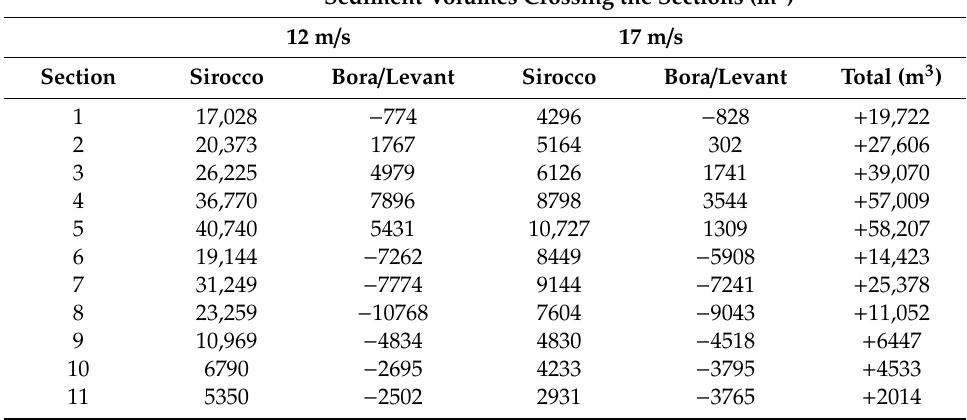
Table 3. Sediment volumes crossing sections during each wind event of the simulation of an average year. The positive volumes represent flood directions that move from the sea side towards the inside of the lagoon, the negative ones are ebb directions which move from the inside towards the outside.